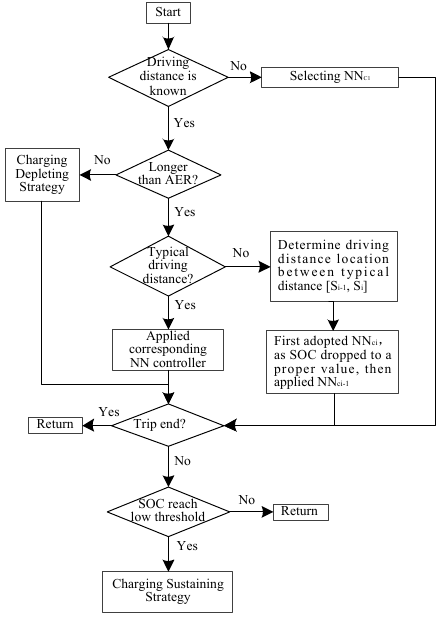
Figure 11. Flowchart of the operation of the controller selection module in IEMC_NN.